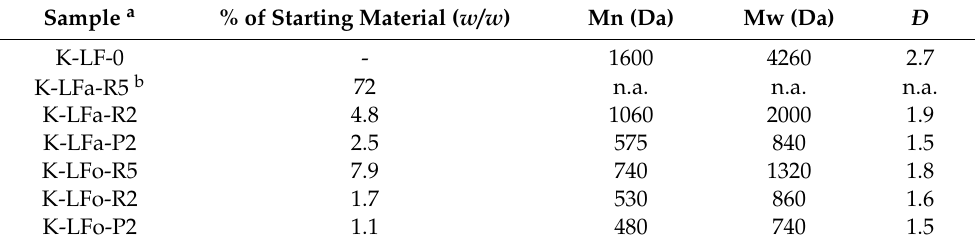
Table 2. GPC analysis (molecular weights Mn and Mw, polydispersity index Ð of all delivered fractions of aqueous and organic processes fractionation of